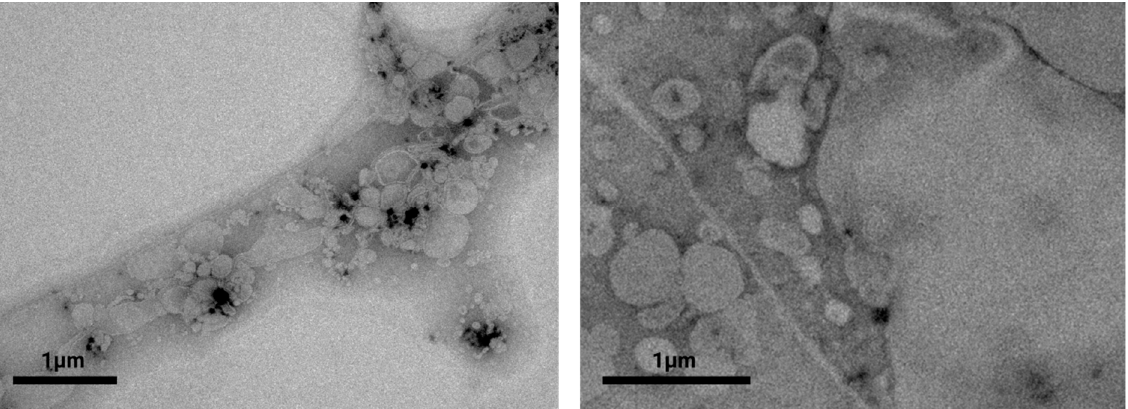
Figure 5. TEM micrographs of the collagen–hyaluronic acid hydrogel obtained in the dried state show a 4800-fold ( left ) and 6800-fold magnification ( right ).